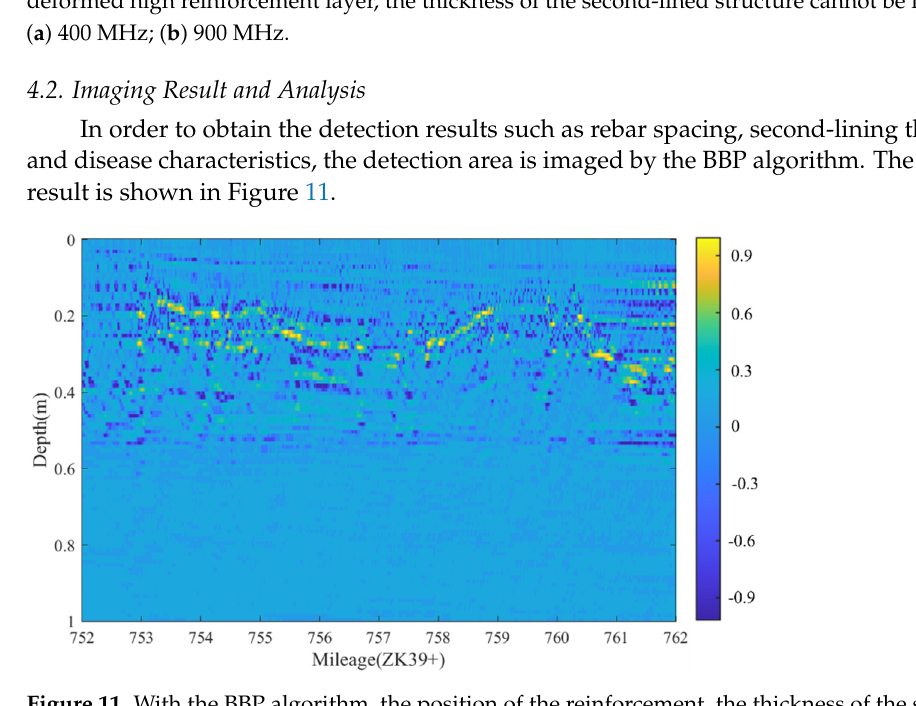
Figure 11. With the BBP algorithm, the position of the reinforcement, the thickness of the structural layer, and the deformation of the reinforcement layer are clearer in the image.